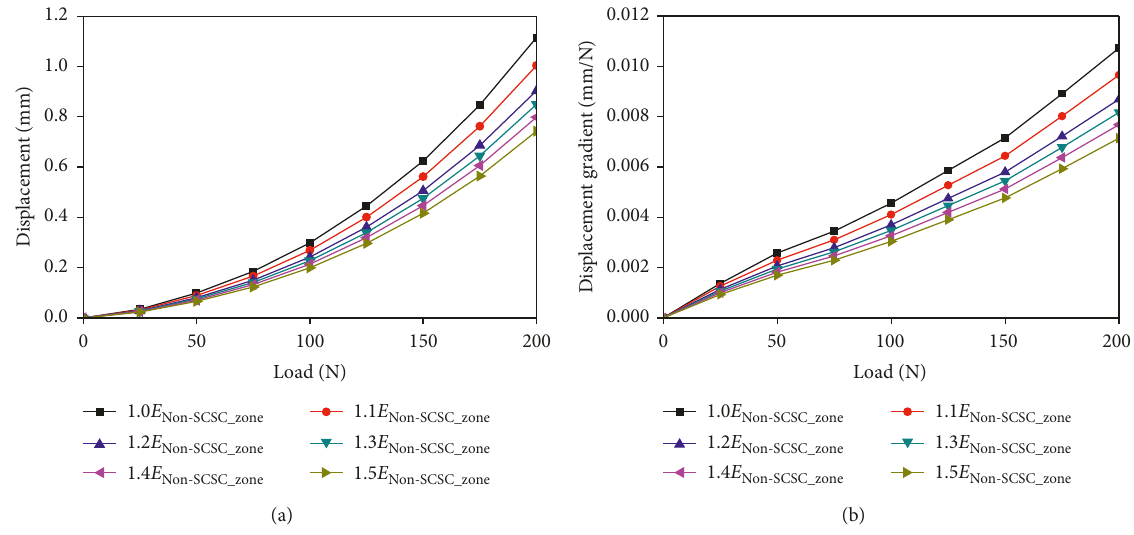
Figure 14: Load-displacement curves and load-displacement gradient curves of the CCFSTP under various E